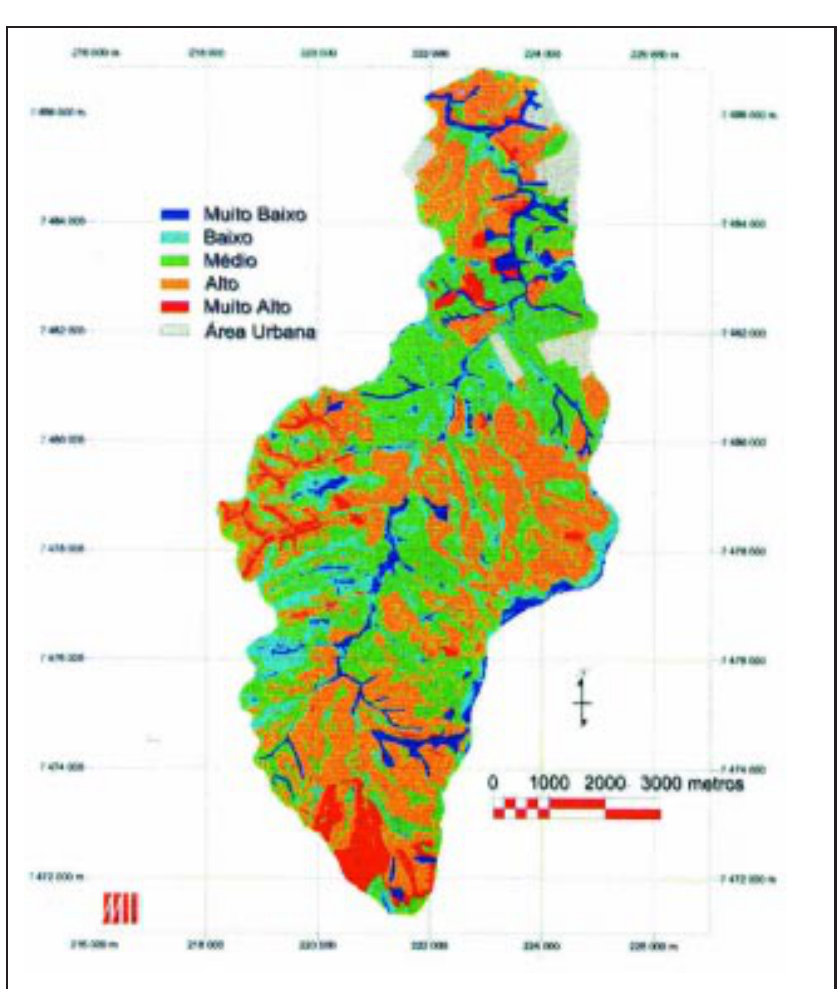
Figura 1. Mapa de risco de degradação das terras para o cenário de uso atual (SIG- TNTmips